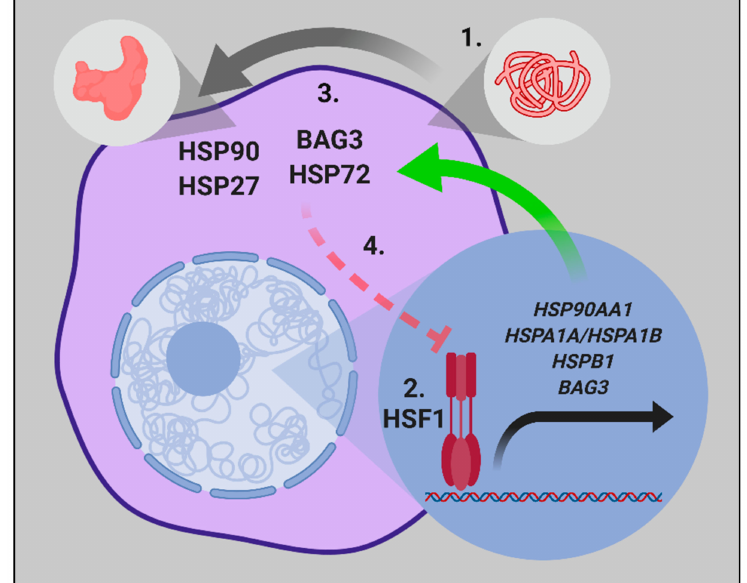
Figure 1. The central dogma of the heat shock proteins-1 (HSP1) mediated proteotoxic stress response. ( 1 ) Cellular stressors such as heat shock, oxidative stress, exposure to heavy metals, or proteasome inhibition, which induce increased levels of non-native protein conformations (proteotoxic stress) leads to the activation of HSF1. ( 2 ) HSF1 translocates to the nucleus, and HSF1 trimers rapidly bind to heat shock elements (HSE) in the promoter region of stress-inducible genes and transactivates mRNA expression. ( 3 ) Increased cytosolic HSP levels promote the refolding of proteins in non-native conformations to achieve the native functional protein structure. ( 4 ) As proteostasis is restored, a negative feedback loop exists, where HSP72 then inhibits the HSF1 activity